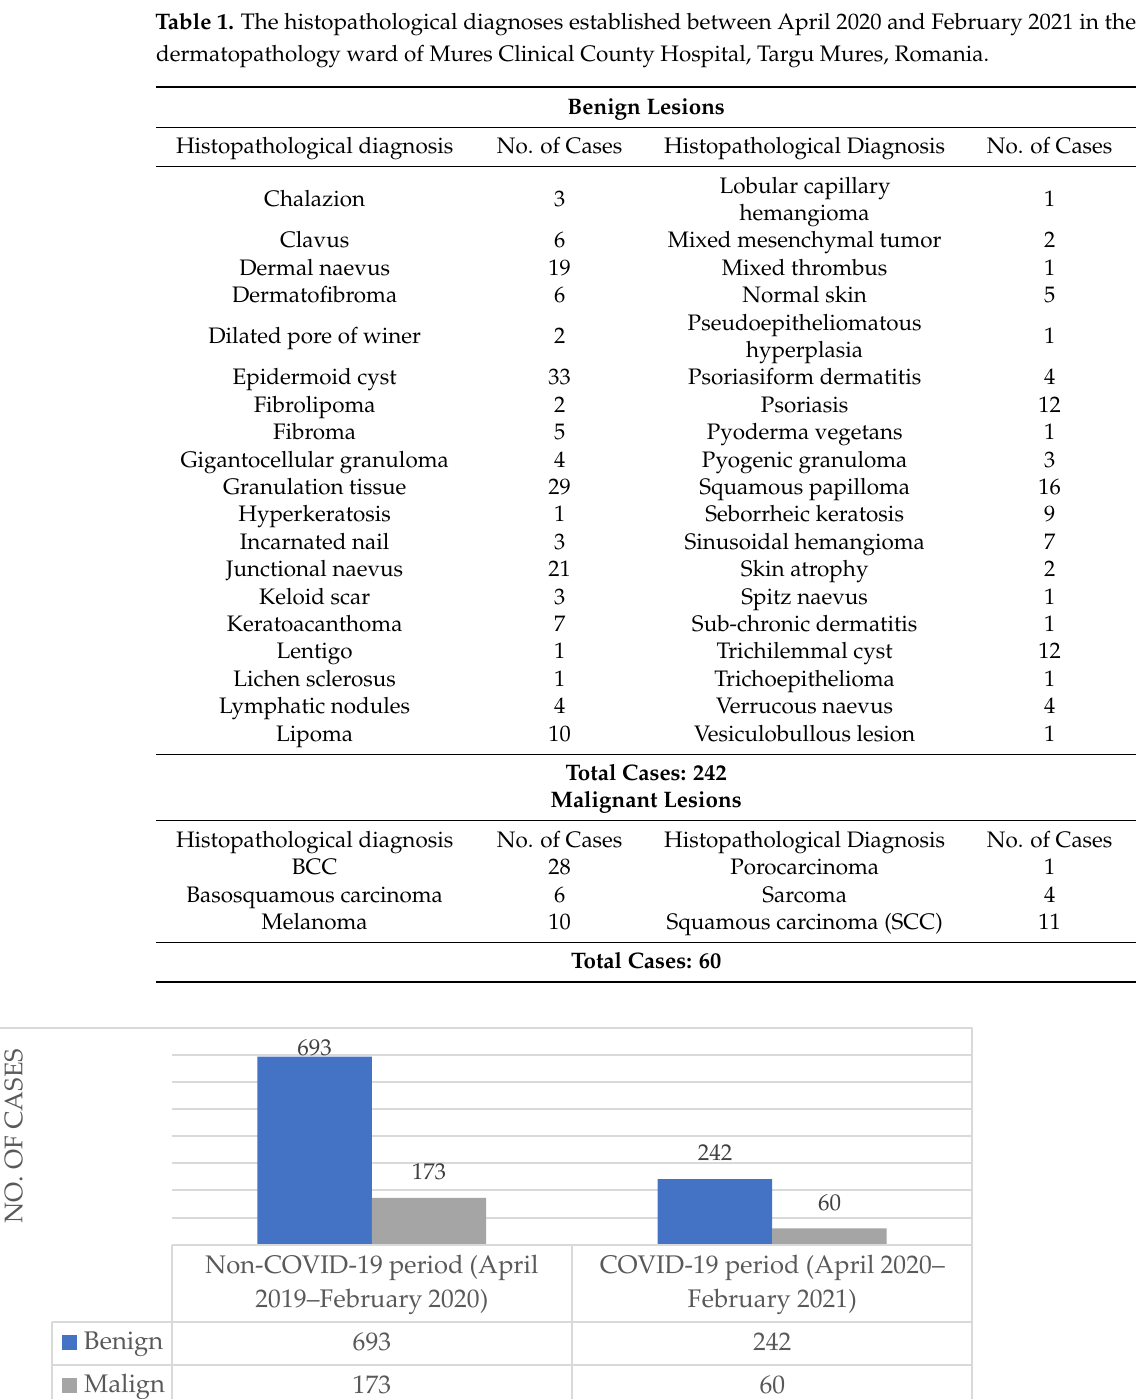
Table 1. The histopathological diagnoses established between April 2020 and February 2021 in the